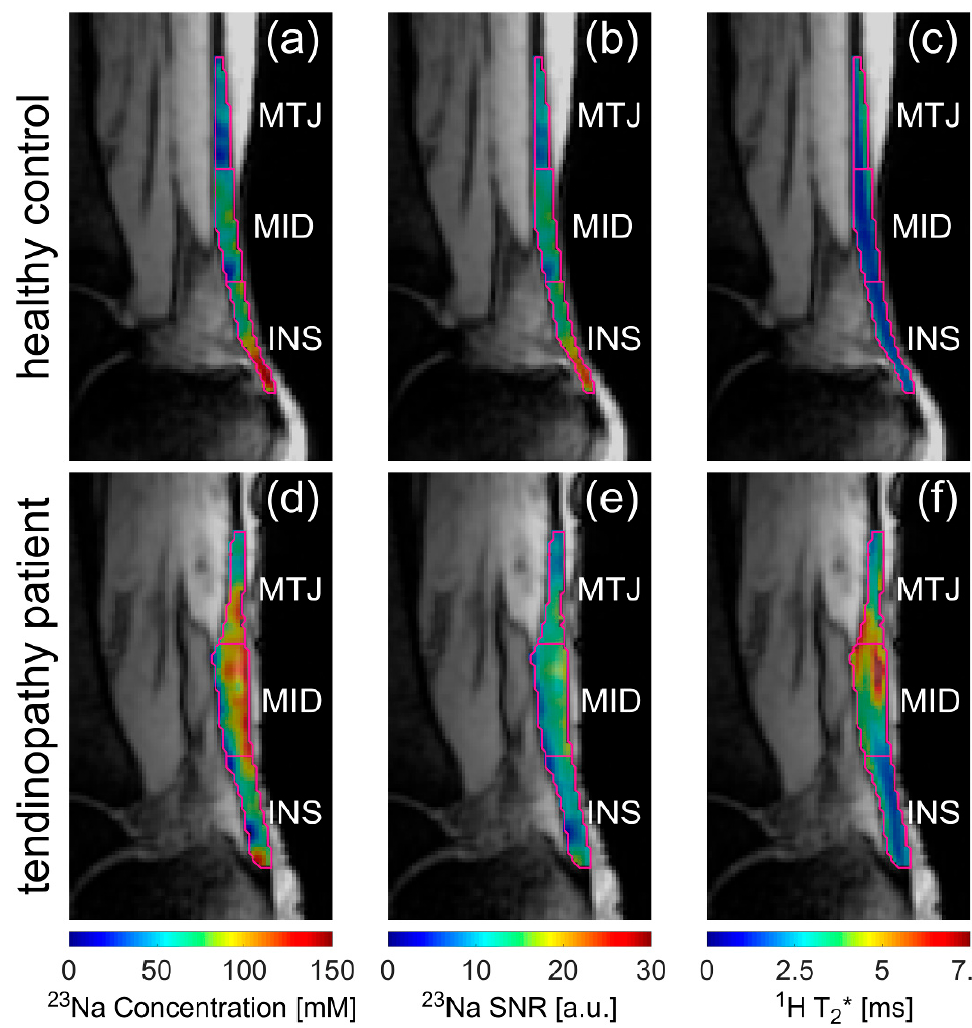
Figure 3. Apparent tissue sodium concentration (aTSC) ( a , d ) and 23 Na signal-to-noise ratio (SNR) ( b , e ) as well as 1 H T 2 * maps ( c , f ) overlaid onto the 1 H images acquired with the density-adapted radial sequence using TE = 9 ms. The overlaid colormaps are displayed for an exemplary healthy control ( a – c ) and the patient with Achilles tendinopathy ( d – f ). The different AT ROIs (INS, MID and MTJ) are outlined and labelled according to their position. Table 3. Resulting p -values for testing significant differences between the different ROIs in the AT for the healthy controls. The parameters aTSC, 23 Na SNR and 1 H T 2 * and their relative standard deviations were tested with a significance level of p ≤